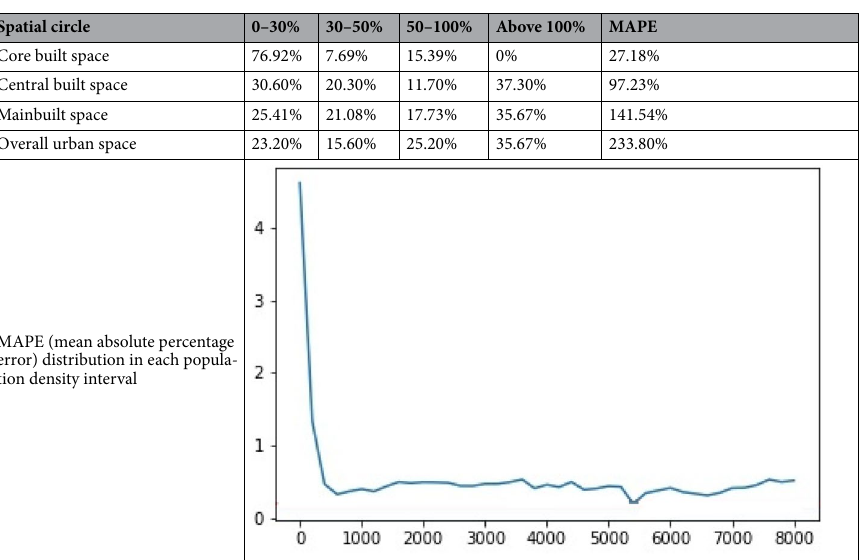
MAPE (mean absolute percentage error) distribution in each